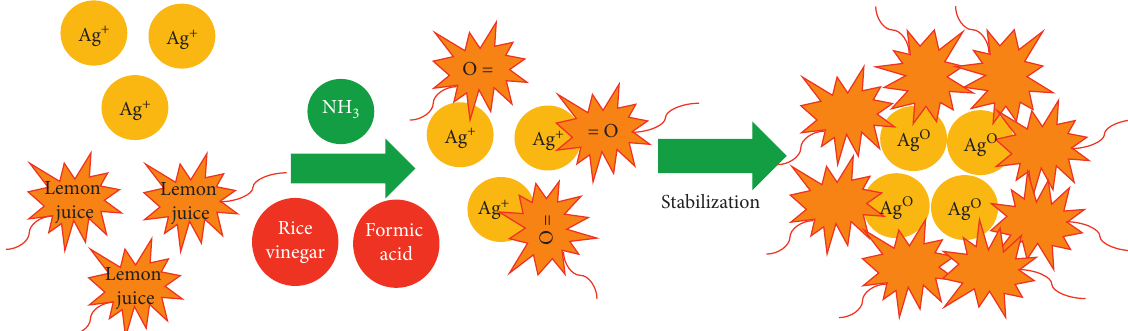
Figure 6: The mechanism diagram of the preparation process of silver nanoparticles using the lemon juice extract and rice